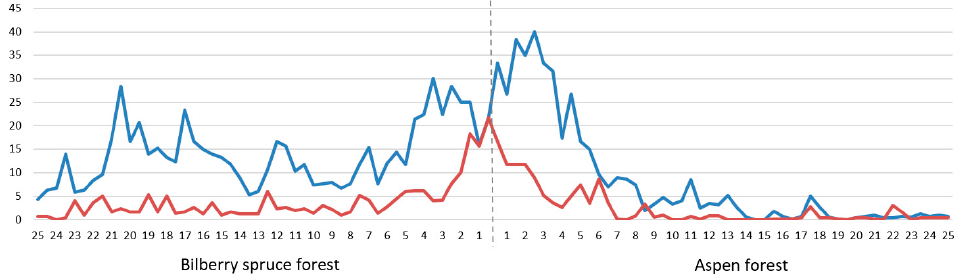
Figure 4. Alteration of the percentage covers of bilberry and cowberry in the transect running from bilberry-type spruce forest (on the left) into grass-forbs-type aspen forest (on the right) (site 1): the ordinate indicates the percentage cover of plant species ( bilberry, cowberry); the abscissa represents the distance from the interface of the communities towards the spruce forest and towards the aspen forest (in meters); dashed line is the interface of the communities (quoted from: [26]). The species composition of vascular plants was determined for each EC zone. The vascular species dominance structure in different EC zones was estimated by Pielou’s evenness index, which takes values from 0 to 1, where 1 means that all species are repre- sented in equal numbers. Pielou’s index is a variant of the Shannon index [51]: H/logN,